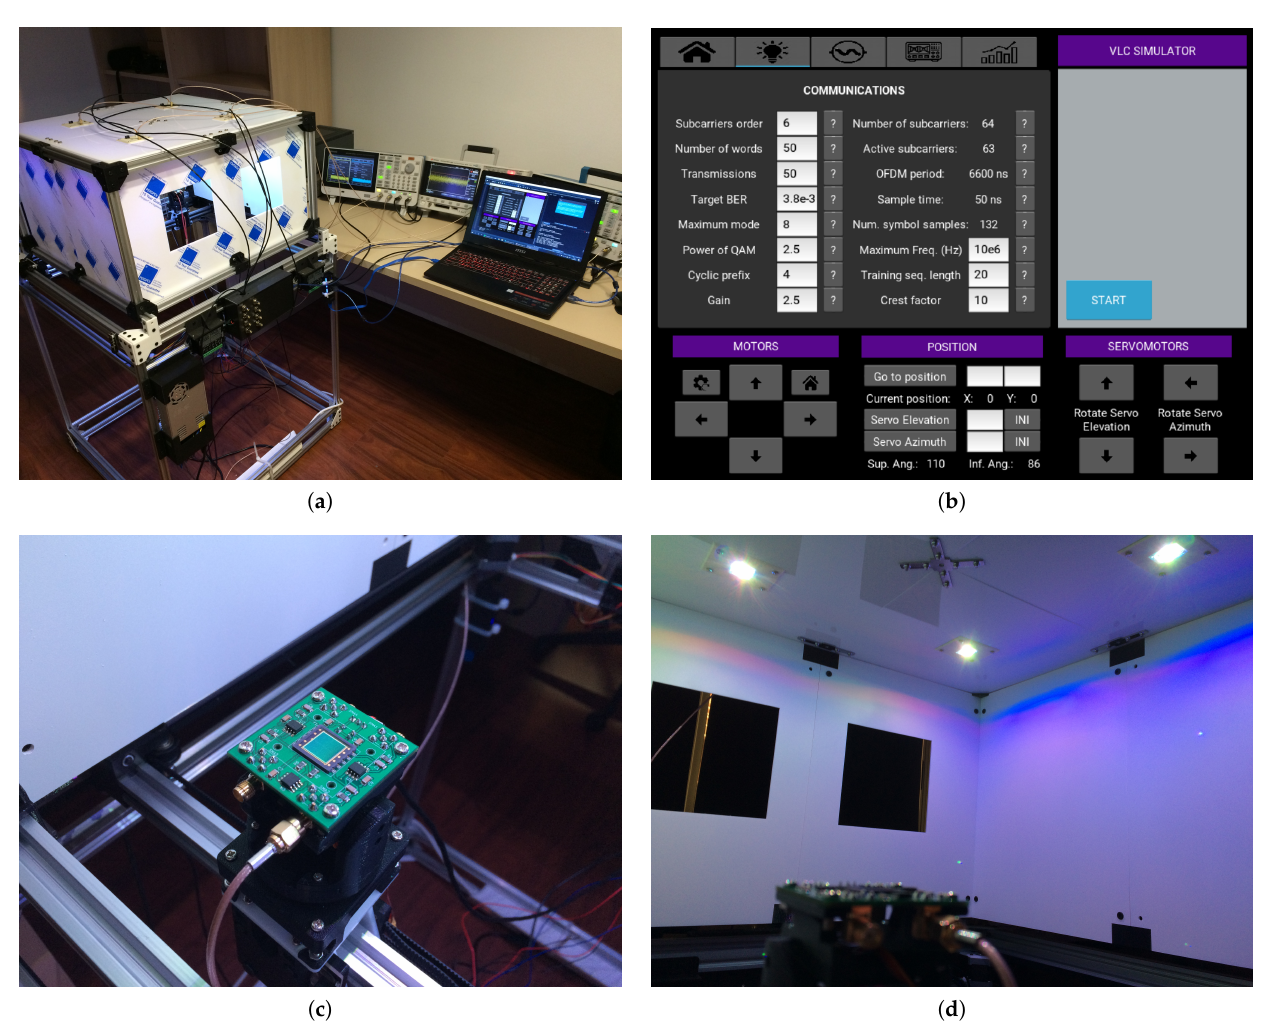
Figure 12. Views of the manufactured mockup: ( a ) General view of the experimental testbed. ( b ) Graphical user interface developed in Python. ( c ) Zoom of optical receiver. ( d ) Zoom of emitters at